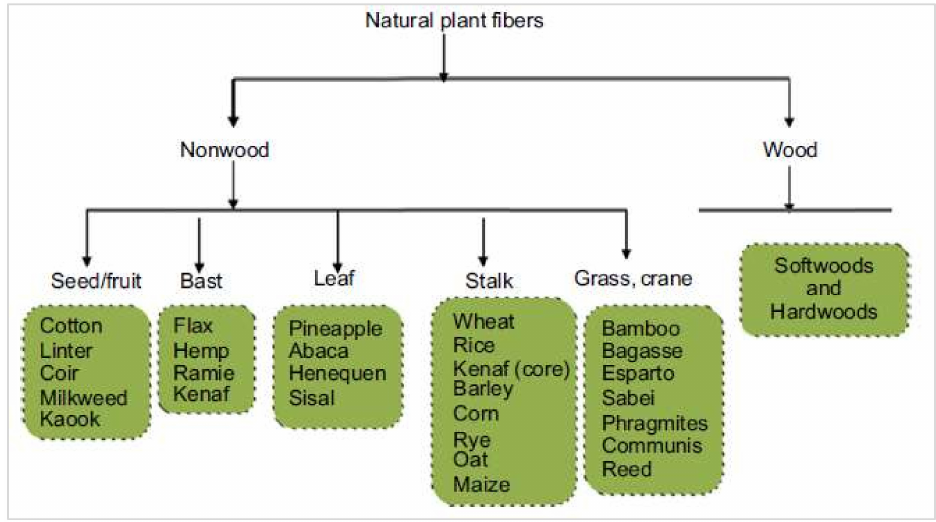
Figure 2. Natural fibers’ classification [14].